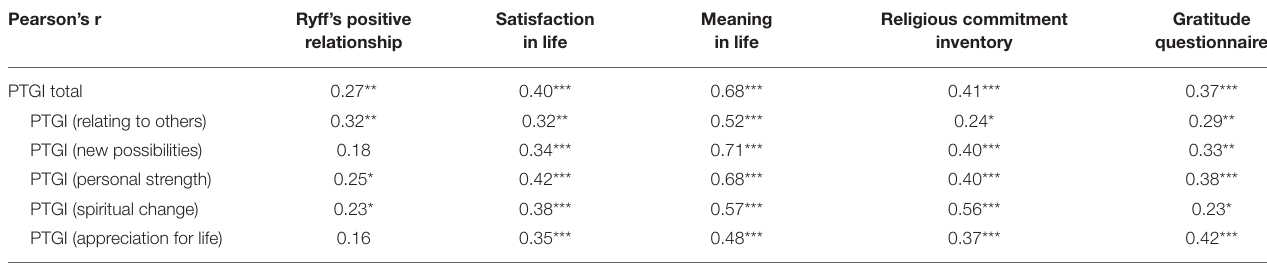
TABLE 2 | Convergence of PTGI with various indicator scales.